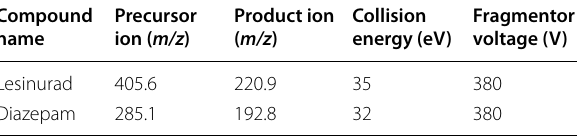
Table 1 MS parameters for lesinurad and